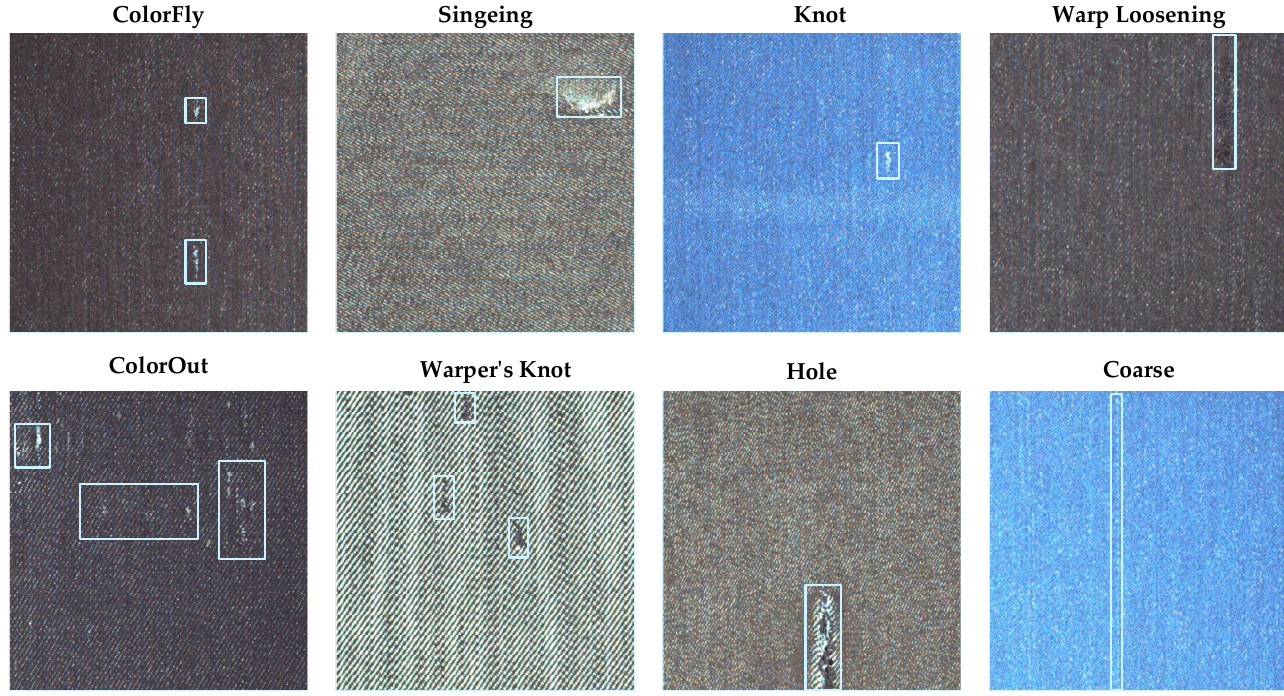
Figure 7. Examples of different types of fabric defects.